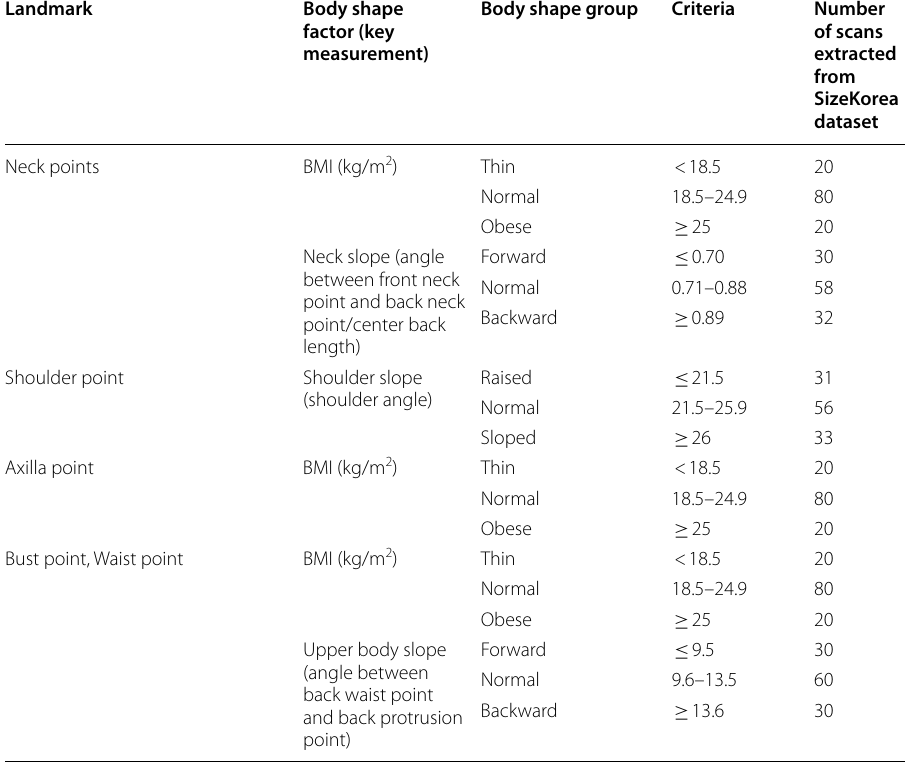
Table 2 Body shape factor and groups related to landmarks Landmark